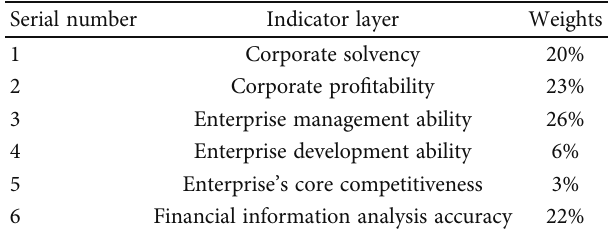
Table 3: Weight analysis results of each